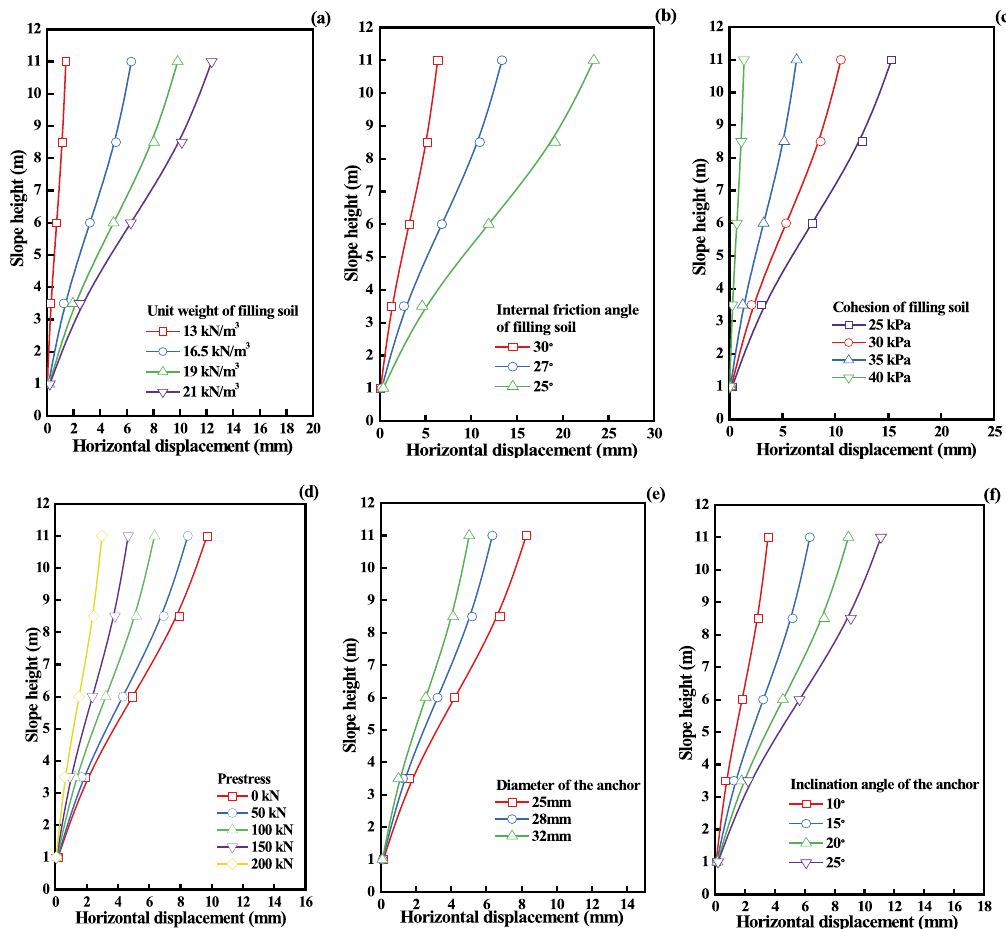
Figure 9. Influence of parameter change on horizontal displacement: ( a ) Unit weight. ( b ) Internal friction angle. ( c ) Cohesion. ( d ) Prestress of the anchor. ( e ) Diameter of the anchor. ( f ) The inclination angle of the